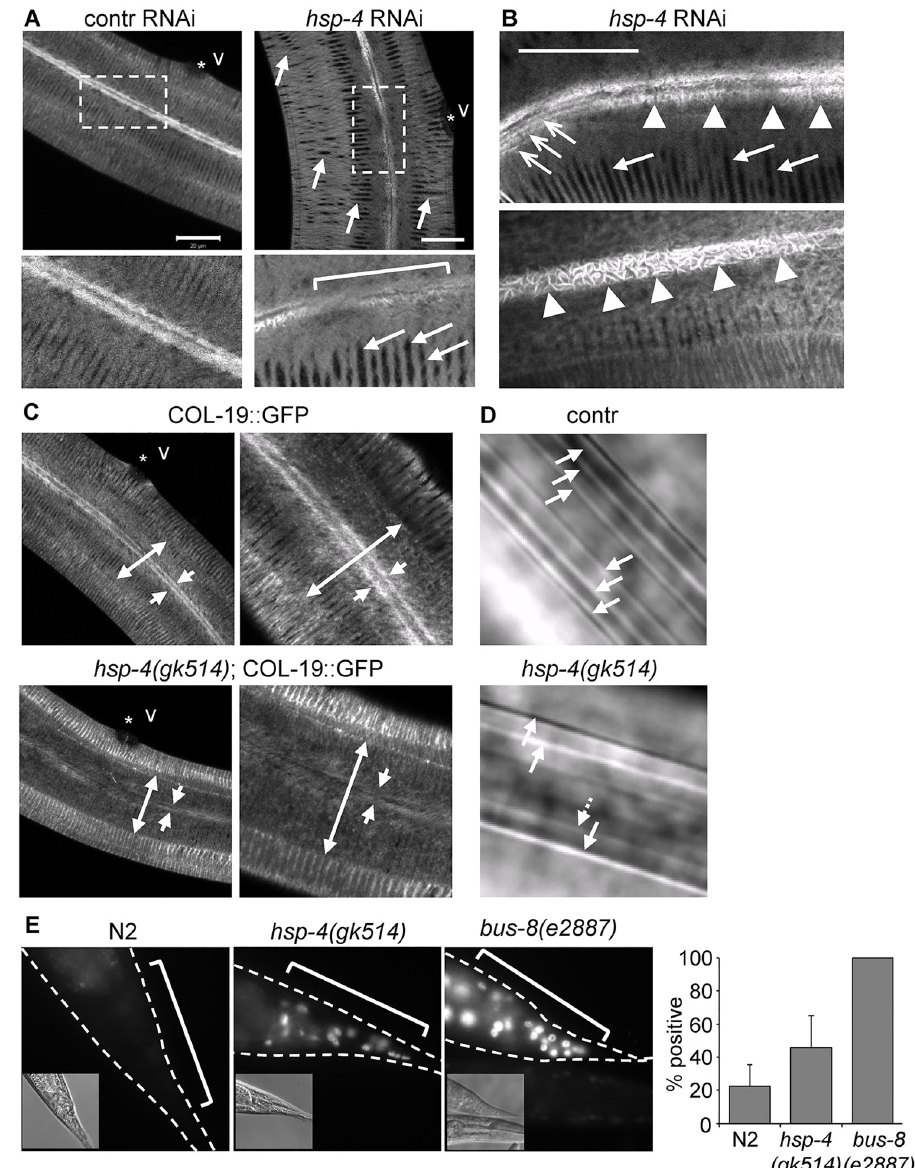
Fig 4. HSP-4/BiP is required for the normal structure and barrier function of the cuticle in adults and alae formation in dauers. (A) Confocal image of COL-19::GFP protein in the hypodermis and alae of a WT (N2) young adult hermaphrodite, fed control RNAi (empty vector, L4440) or hsp-4 RNAi. COL-19::GFP in controls is deposited in the linear circumferential pattern in the hypodermis, and in linear longitudinal pattern underlying the alae structures. hsp-4 RNAi results in abnormal deposition of COL-19::GFP protein, with large visible gaps in the circumferential pattern (arrows) and gaps and abnormal appearance of the longitudinal alae pattern (bracket). Star indicates position of the vulva (v). Lower panels: close views of boxed regions pattern. Scale bar: 20 μ m. (B) Examples of disrupted COL- 19::GFP underlying the alae structures in adult hsp-4 (RNAi) animals. Open arrows indicate area of normal longitudinal pattern, while arrowheads point to disorganized, “spaghetti-like” pattern of COL-19::GFP. Closed arrows point to the gaps in circumferential pattern. Scale bar: 20 μ m. (C) Genetic deletion of hsp-4 results in decreased deposition of the COL-19::GFP protein in the lateral hypodermis. Double-headed arrows span the lateral hypodermis, overlaying the seam; arrows point to the location of the longitudinal COL-19 structures. (D) Dauer alae are abnormal in daf-28(sa191) dauers carrying hsp-4(gk514) deletion allele. Arrows indicate individual ridges; the daf-28(sa191) ; hsp- 4(gk514) dauer shown here has missing or flattened ridges. DIC images. (E) hsp-4 deletion increases permeability of the cuticle to small molecules. Staining of nuclei in live animals treated with DNA-binding Hoechst dye reflects the degree of leakiness of the cuticle. Staining was performed as previously described [59]. Percent animals positive for